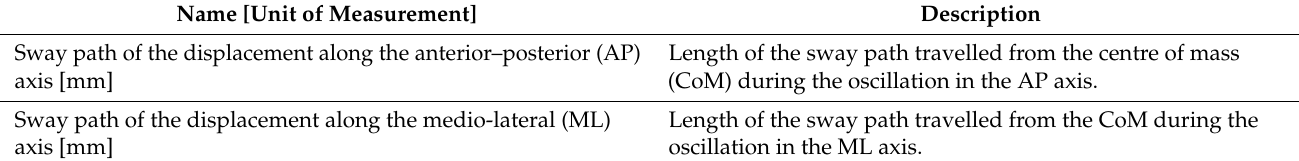
Table 3. Postural parameters analysed during the pre- and post-mechanical peripheral stimulation. Name [Unit of Measurement]